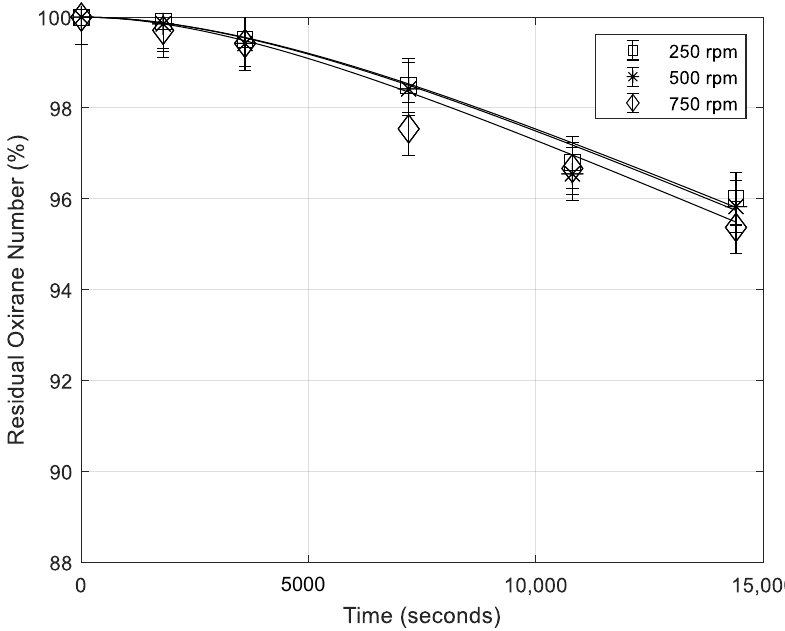
Figure 5. Residual oxirane number profiles in the presence of the same amount of H 3 PO 4 for different stirring rates (rpm = number of stirrer revolution per minute). Points are experimental data lines that are calculated with the developed model (mass of catalyst 0.65 g; temperature 70 °C; mass of formic acid 5.16 g).